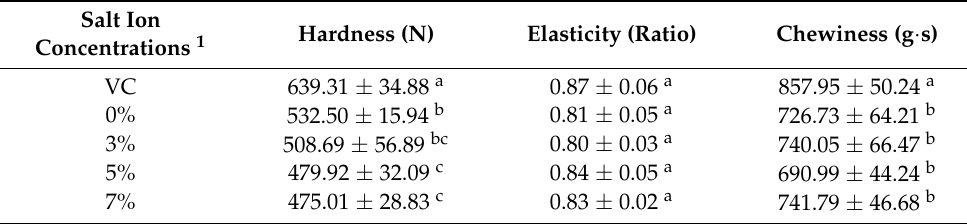
Table 3. Effects of immersion solutions with different salt ion concentrations on the textural properties of